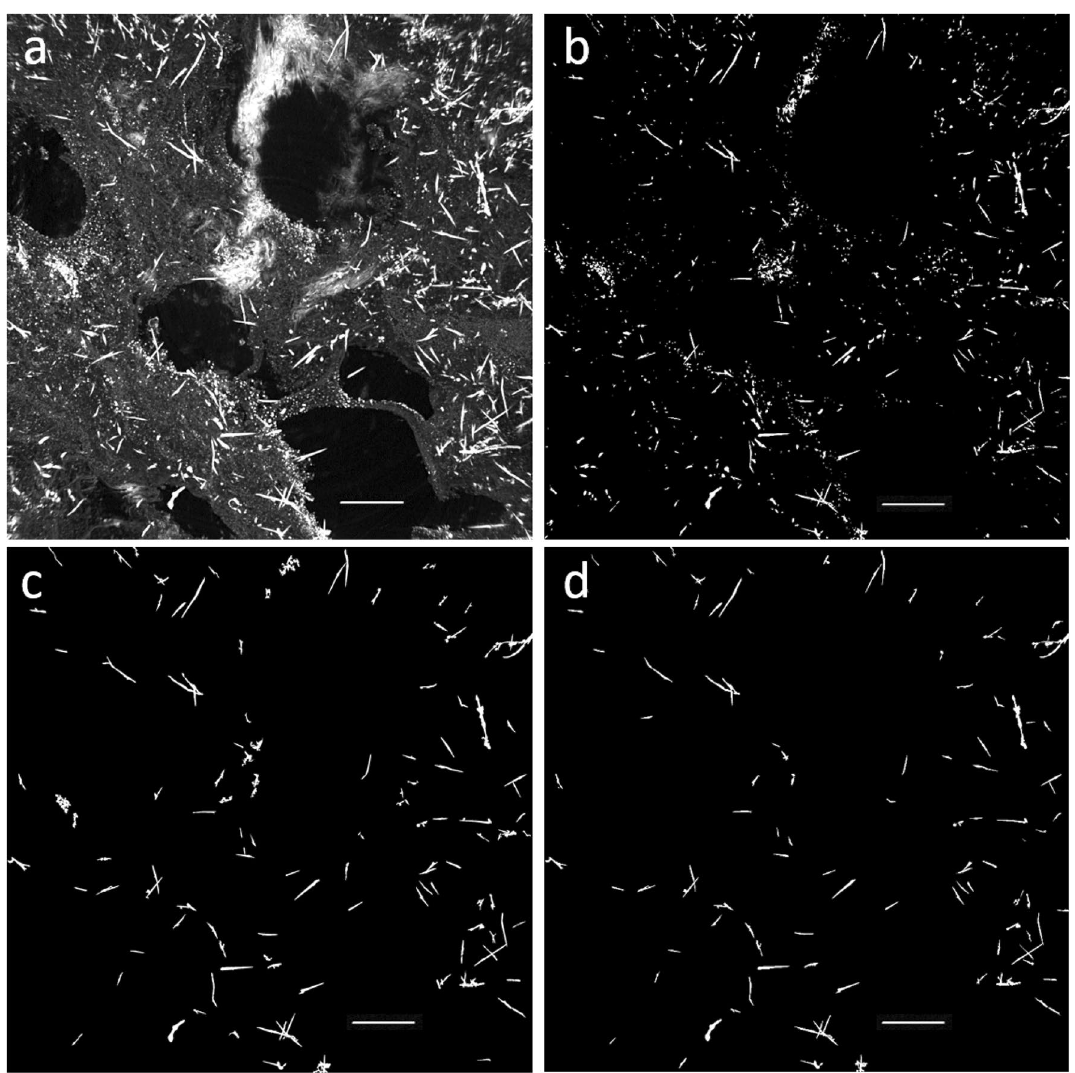
Figure 4. The counting process workflow is shown. ( a ) Original microtomography image projected on a plane for easy of view; ( b ) Segmentation most of the background lung tissue is removed only objects with grey levels in a chosen range survive; ( c ) Size filters only objects in a selected size range are selected, most of the smaller particulate matter or large/higher density background structures are removed; ( d ) Sphericity and solidity filters only objects with low sphericity and solidity values survive (i.e. objects with high aspect ratio are selected). The voxel size is 0.332 × 0.332 × 0.332 µm 3 (isotropic), and the scale bars are 100 µm in